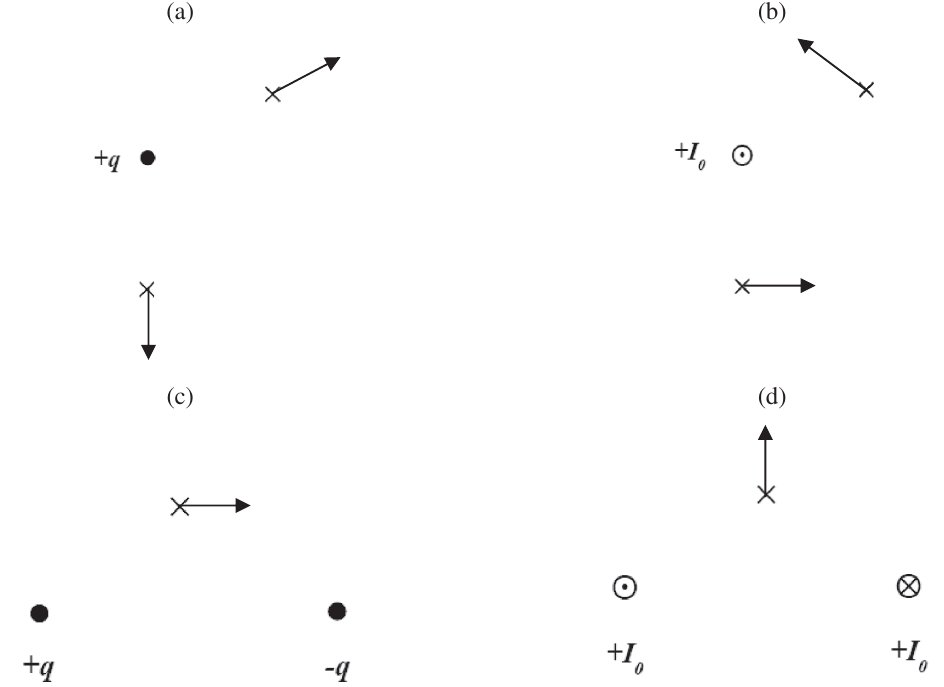
FIG. 2. The expected drawings for the questions of the field and the principle of superposition. On the left are those in the context of electricity. On the right, those in the context of magnetism. (a) The expected drawing for the electric field in question 1. (b) The expected drawing for the magnetic field in item 1. (c) The expected drawing for the electric field in question 2. (d) The expected drawing for the magnetic field in item